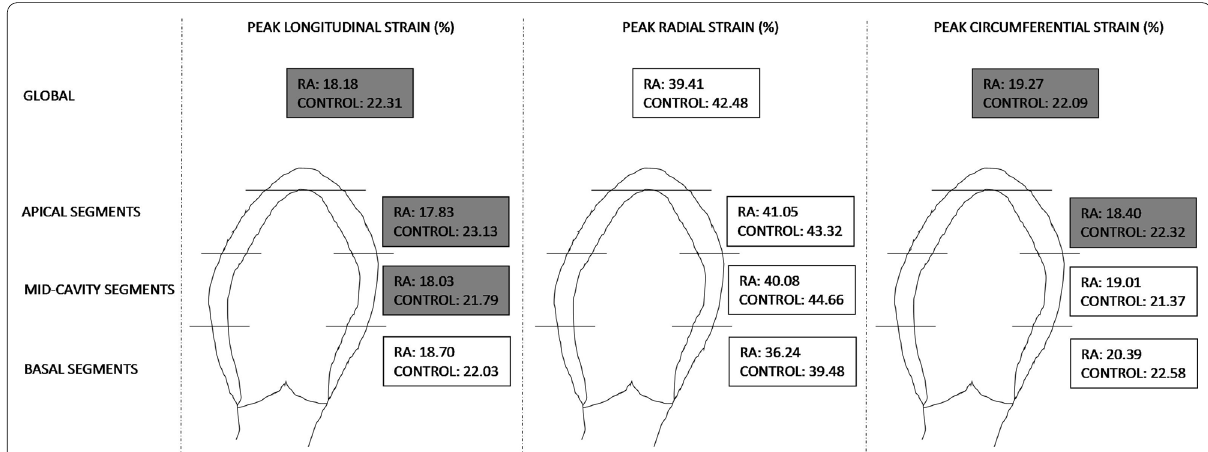
Fig. 4 Parameters of left ventricular myocardial strain assessed by cardiac magnetic resonance feature tracking in the study groups of